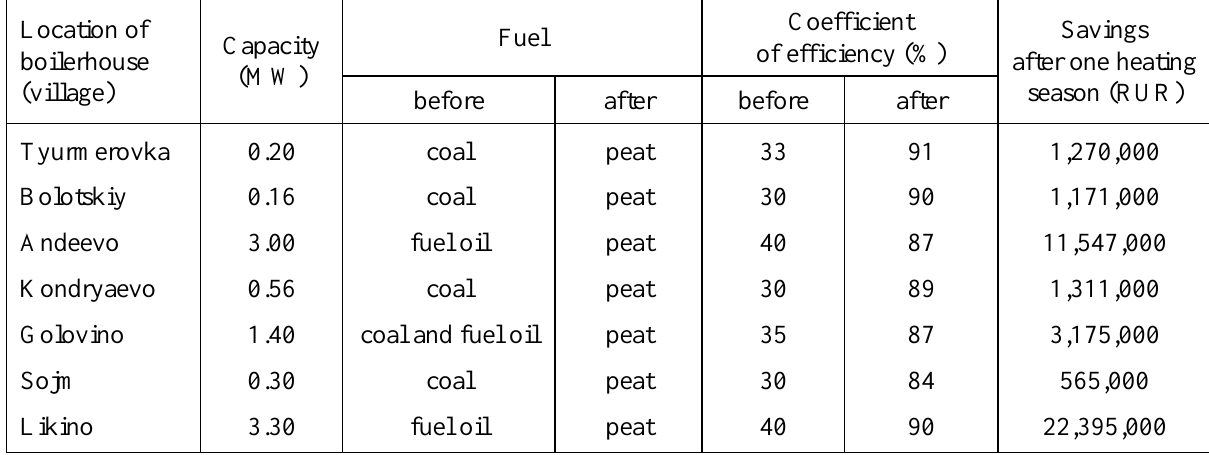
Table 4. The effect of using peat in thermal energy production (ROSTORF & BioEnergo 2014). Location